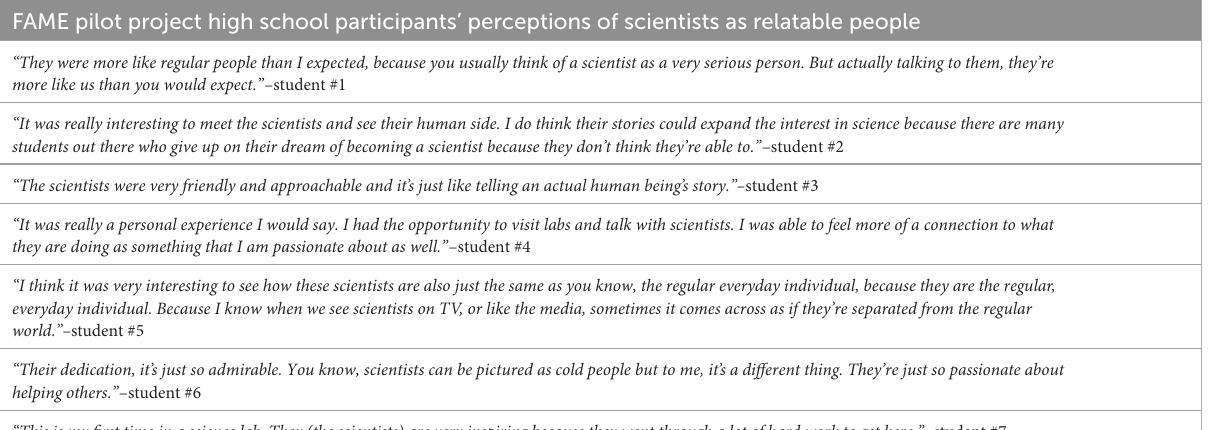
TABLE 4 FAME pilot project high school participants’ perceptions of scientists as relatable